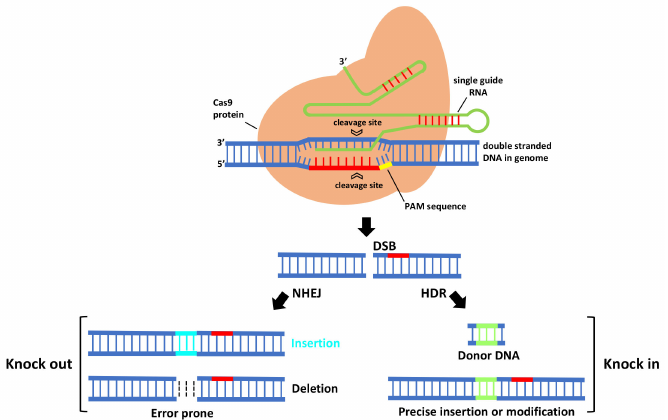
Figure 1. The mechanism of CRISPR-Cas9-mediated genome engineering in plants. A single guide RNA recognizes a region in the genome followed by a PAM sequence, and recruits a Cas9 protein that will cleave DNA, creating a double-stranded break that is repaired by error-prone non-homologous end-joining (NHEJ) and homology-directed repair